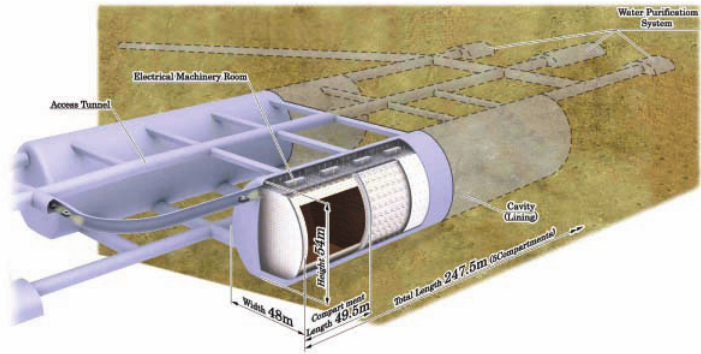
Figure 15: Schematic view of the Hyper-Kamiokande detector. The detector consists of two cylindrical water tanks lying side by